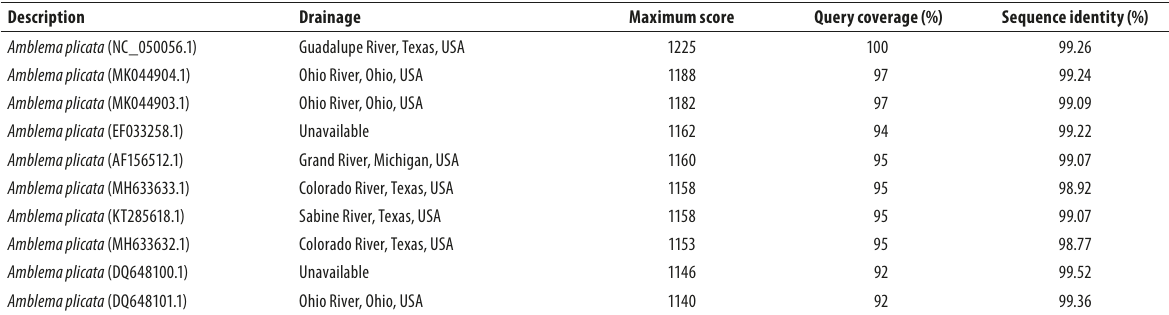
Table 1. Details for the top 10 BLASTN results producing significant alignments with the CO1 sequence generated using the specimen collected from the Choctawhatchee River. The BLASTN search was performed 20 April 2021. Description